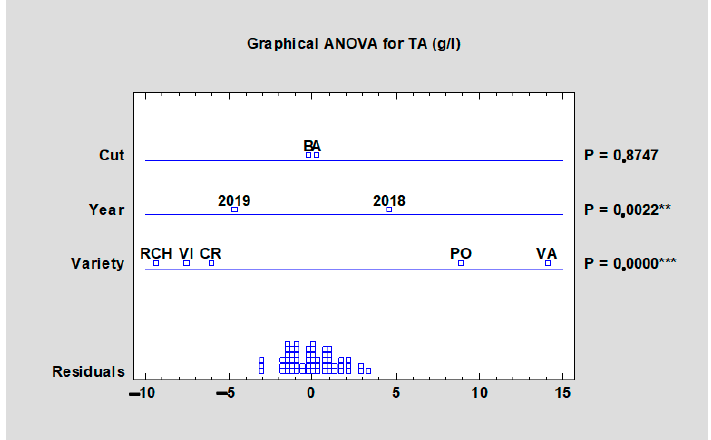
Figure 10. Effect of the experimental year, cultivar, and term of the harvest on the total acid content in rhubarb cultivars. Abbreviations: PON, ´Poncho´; CRE, ´Canadian Red´; VAL, ´Valentine´; RCH, ´Red Champagne´; VIC, ´Victoria´. LSD test with significance: p ≤ 0.01 (**) or p ≤ 0.001 (***).